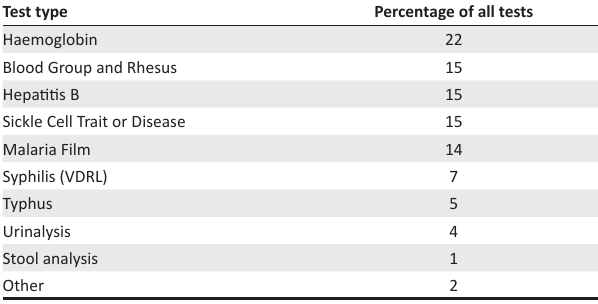
TABLE 3: Summary of test types performed at the Tropical Laboratory Initiative facility, Tontokrom, Ghana,